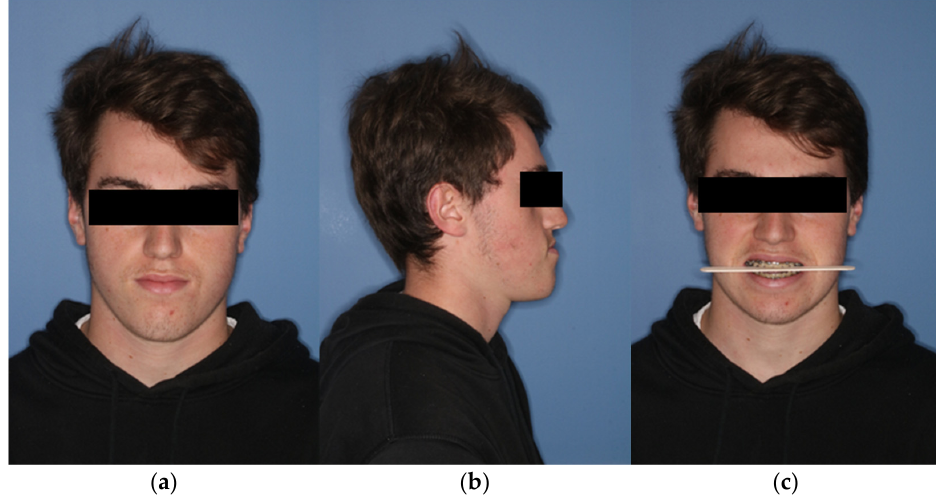
Figure 1. Extraoral view of the patient preoperatively. ( a ) En-face image. ( b ) Profile view from right ( c ) Frontal image showing the occlusal plane.